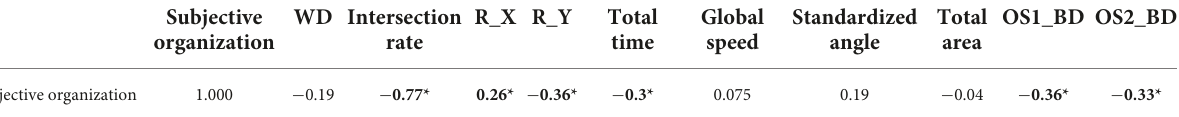
TABLE 2 Spearman’s ρ correlation between the indexes and the subjective organization.